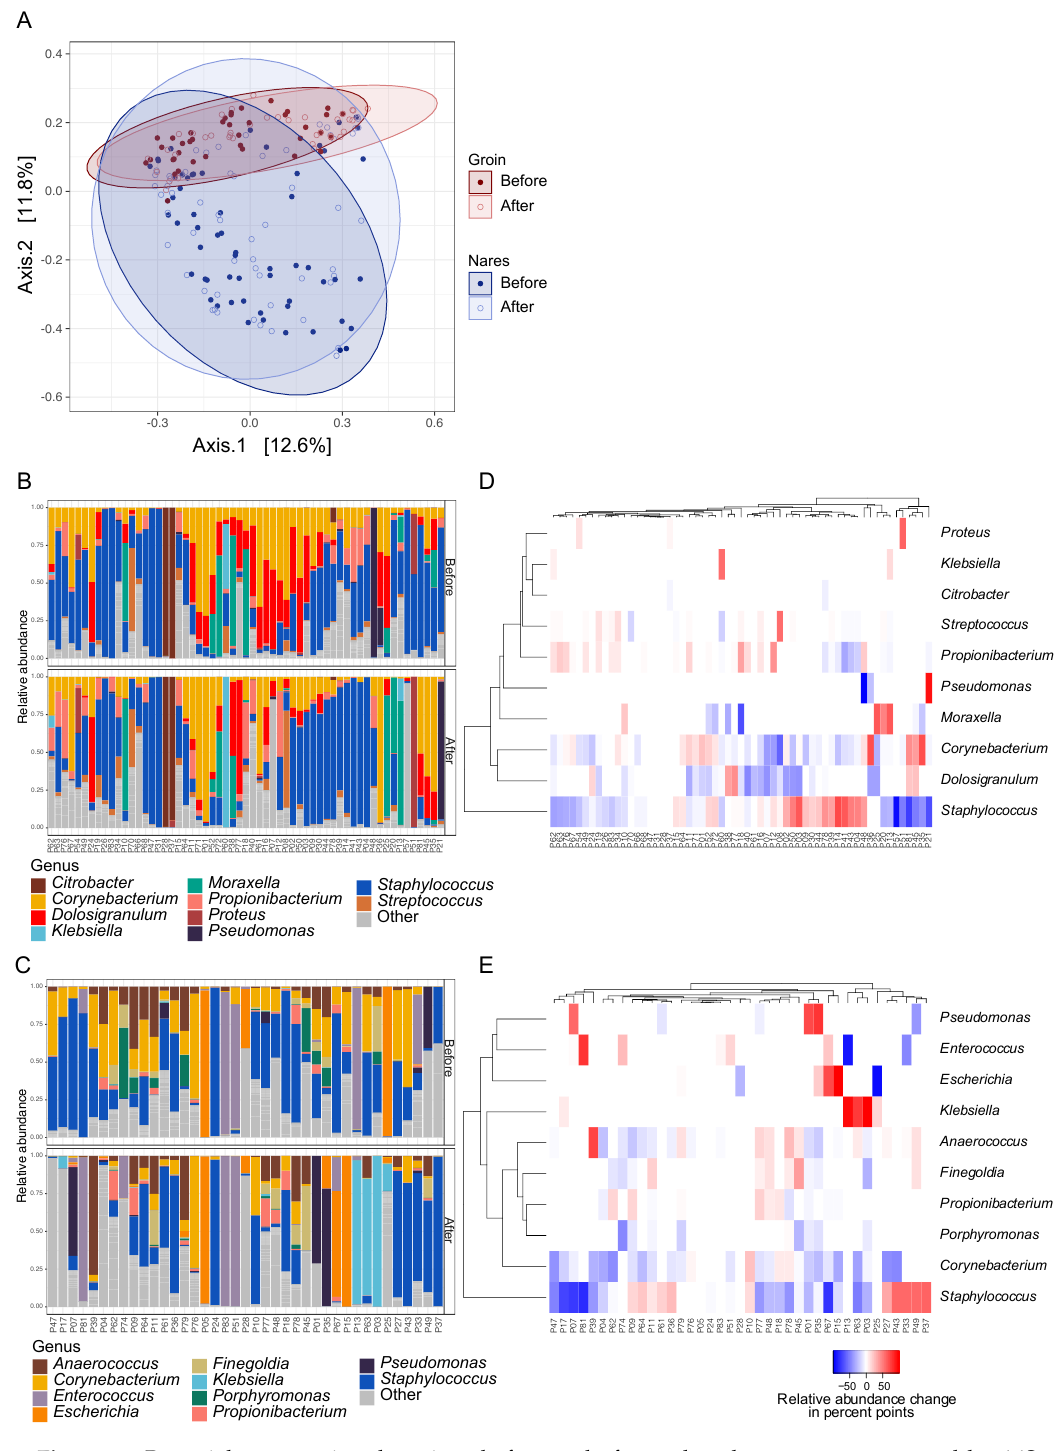
Figure 1. Bacterial community alterations before and after arthroplasty surgery assessed by 16S rRNA (V3-V4) gene sequencing. ( A ) PCoA plot of Hellinger transformed count data based on Bray–Curtis dissimilarity measures. ( B ) Bar plots of 59 bacterial communities from nares and ( C ) 39 groin communities before and after arthroplasty. Heatmaps showing patient-wise relative alterations in percentage points of the 10 most abundant bacterial genera from ( D ) nares and ( E ) groin before compared to after arthroplasty. Patients are clustered according to their similarity in relative abundance alteration for the top 10 most abundant genera. For information on prevalence data for selected bacterial species detected in this study, please refer to Figure